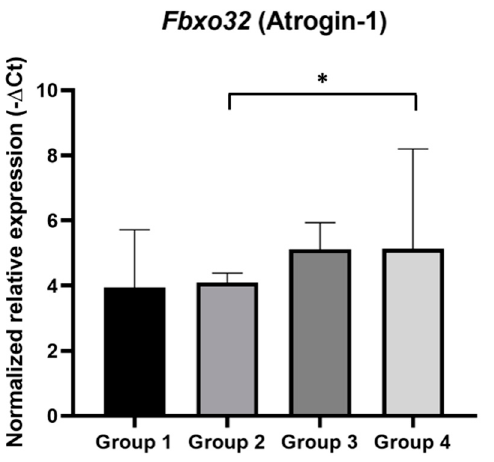
Figure 8. Normalized relative expression of Fbx32 mRNA in mice gastrocnemius samples. The Fbxo32 mRNA expression was normalized using the combined expression of the control genes, Hprt and Tbp . Fbxo32 expression was significantly increased in HPV + mice with DMBA (Group 4) (* p < 0.05). Group 1: HPV − without DMBA application ( n = 10); Group 2: HPV − with DMBA application ( n = 10); Group 3: HPV + without DMBA application ( n = 10); Group 4: HPV + with DMBA application ( n = 10).